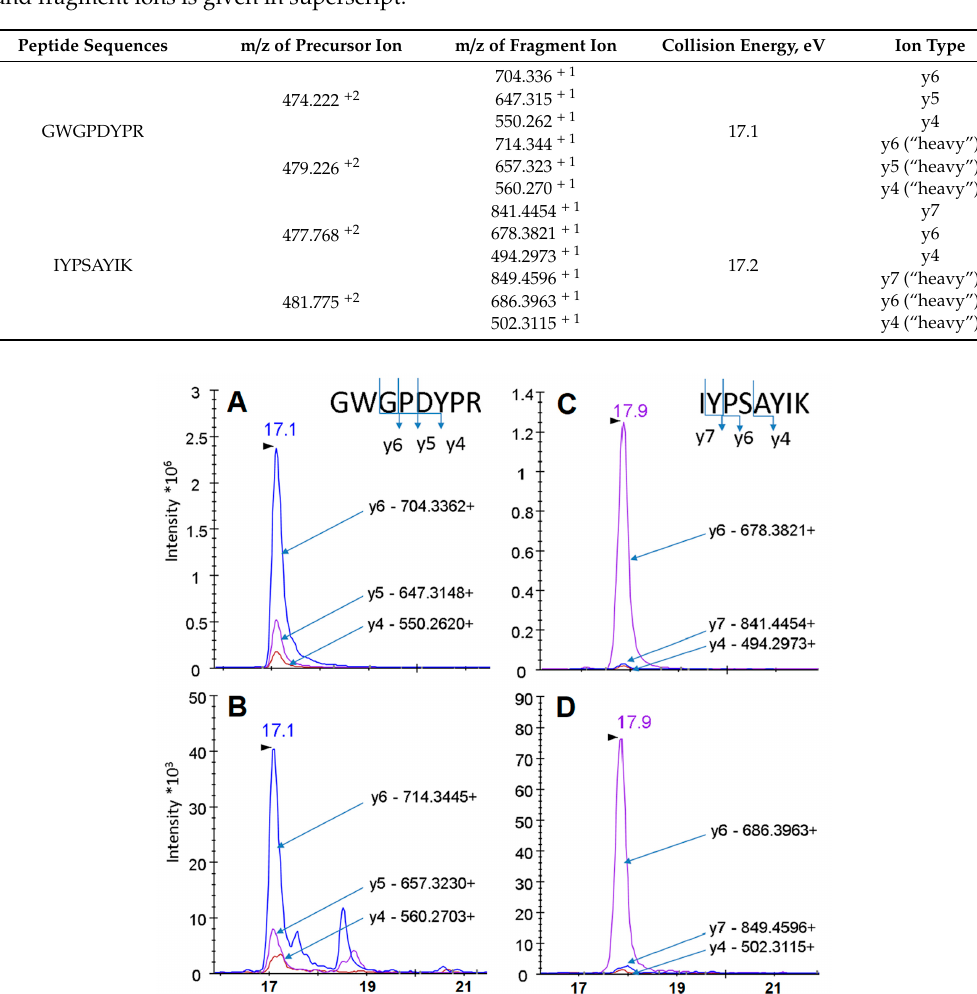
Table 2. List of transitions for the selected proteotypic peptides of SMAD4. The charge of the precursor and fragment ions is given in superscript.